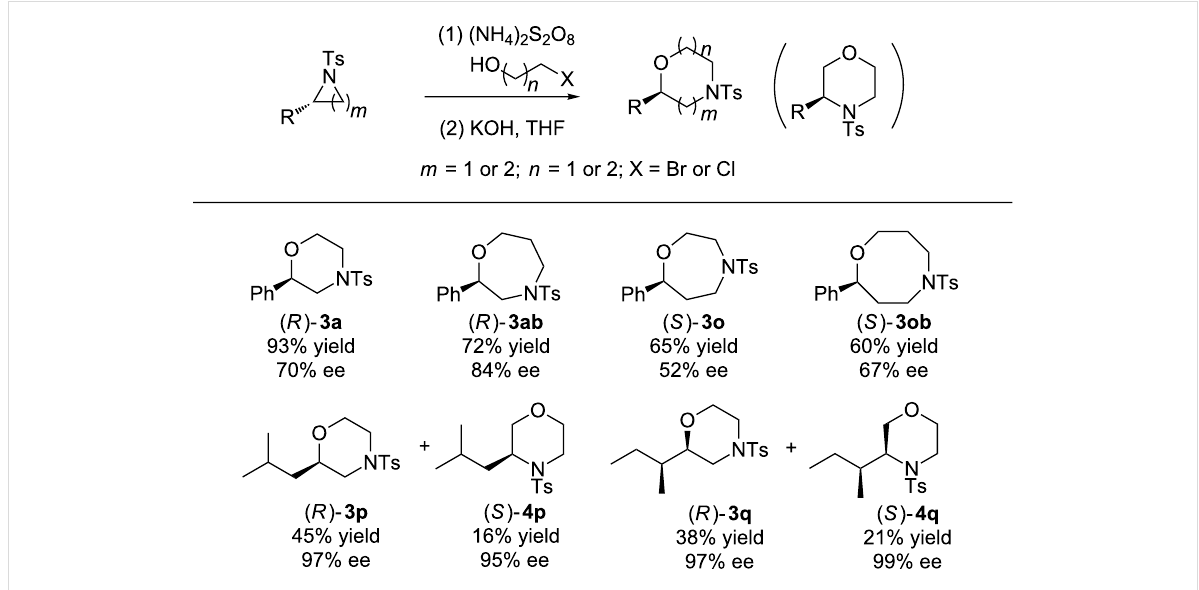
Scheme 3: Metal-free one-pot synthesis of optically pure morpholine derivatives from chiral